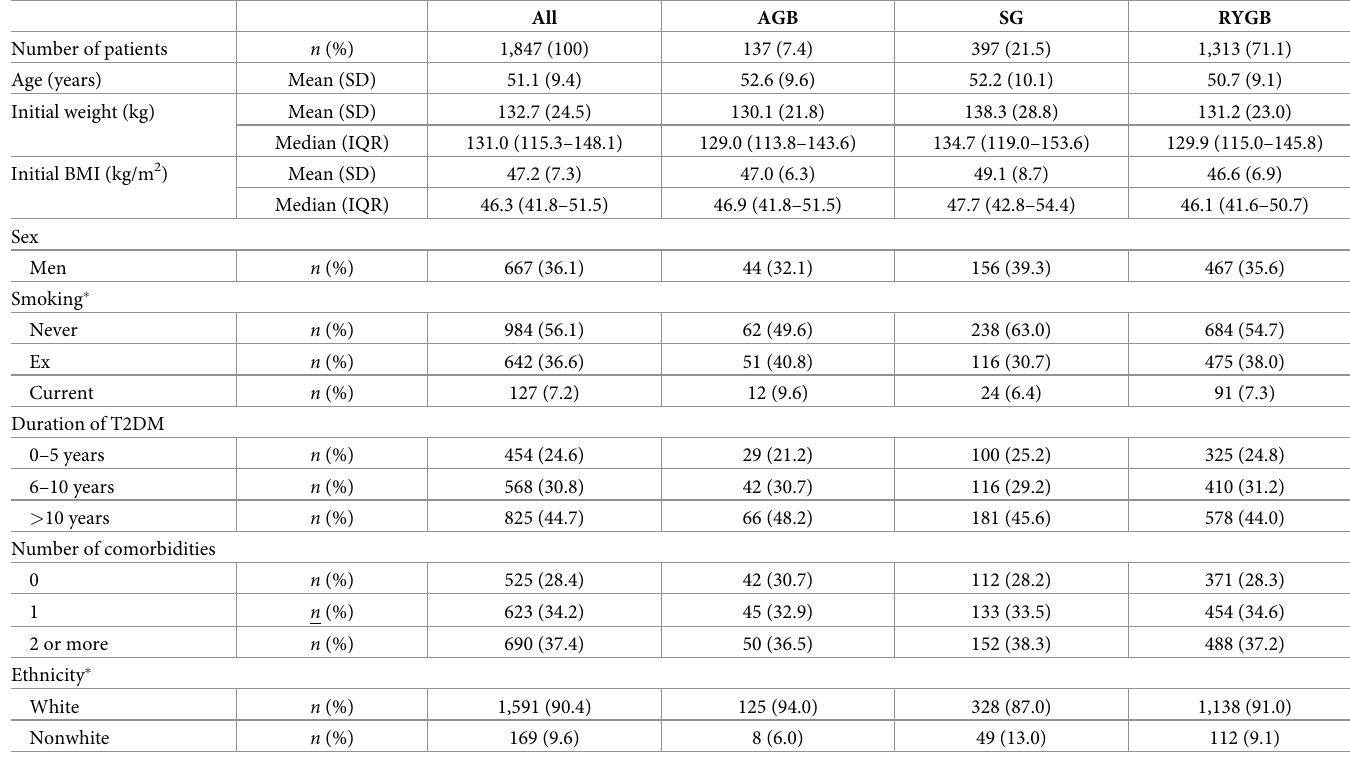
Table 1. Baseline demographic data for surgical patients by procedure ( n = 1,847).